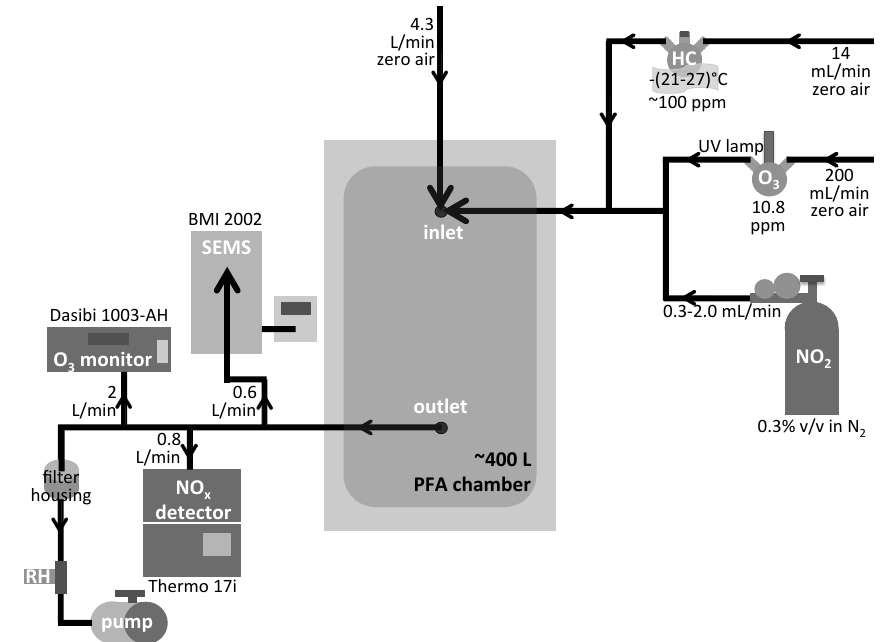
Figure 2. Reed environmental chamber (REC) schematic for the experiments described here.